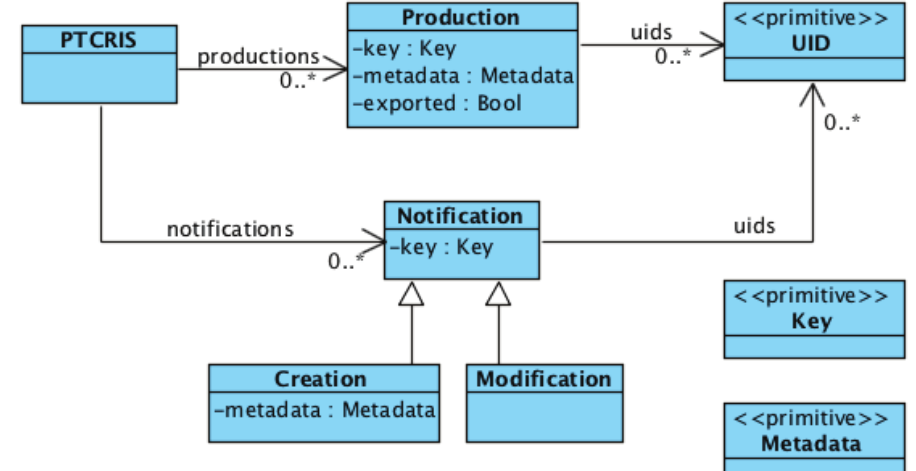
Figure 3. Overview of a PTCRIS service data